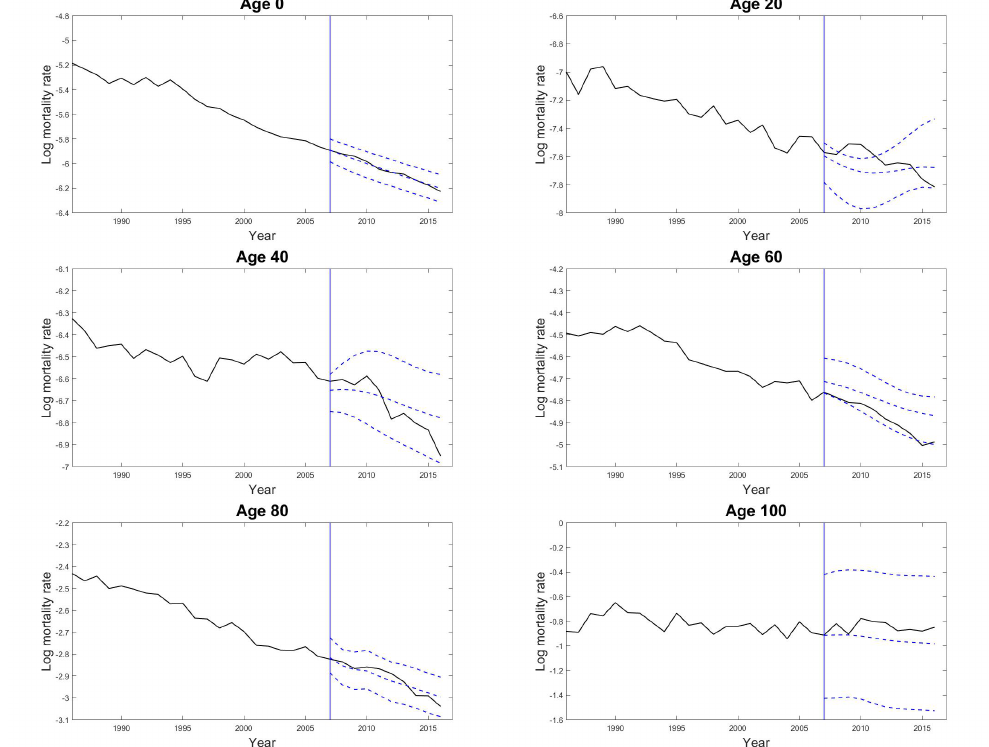
Figure 3. Predicted male mortality rates of the selected age groups from age 0 to age 100 with 20-year age intervals using the proposed GPR model from the year 2007 to the year 2016 based on the observations from the year 1947 to the year 2006 in Japan. The solid lines are the observed values, and the dashed lines are the predictions and the 95% prediction intervals. The vertical line indicates the starting point of the